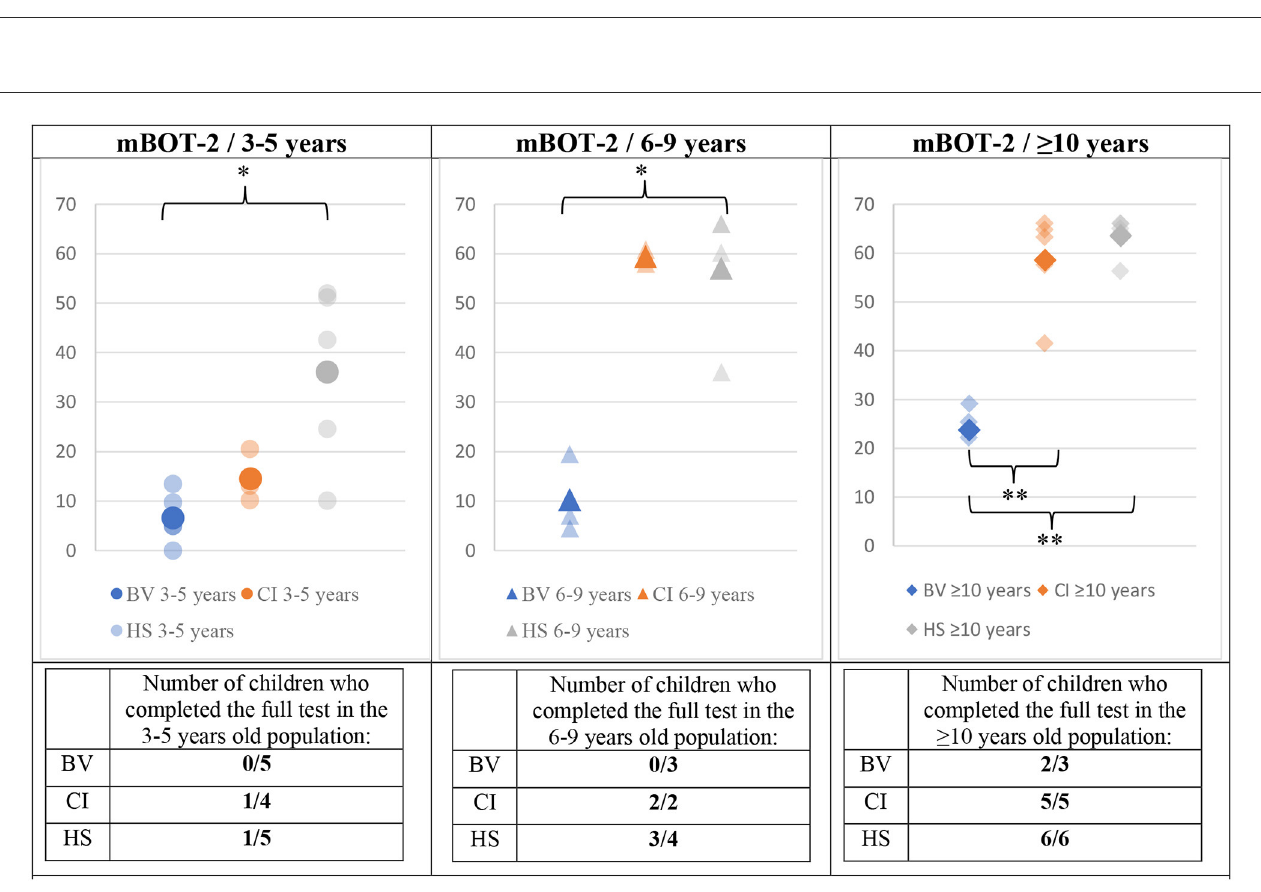
FIGURE4 Means (solid symbols) and individual results (semi-transparent symbols) of the GBT in DL for the three age sub-groups, from left to right; 3–5/6–9/ ≥ 10 years old. * p < 0.017/** p < 0.004 (with Bonferroni correction).